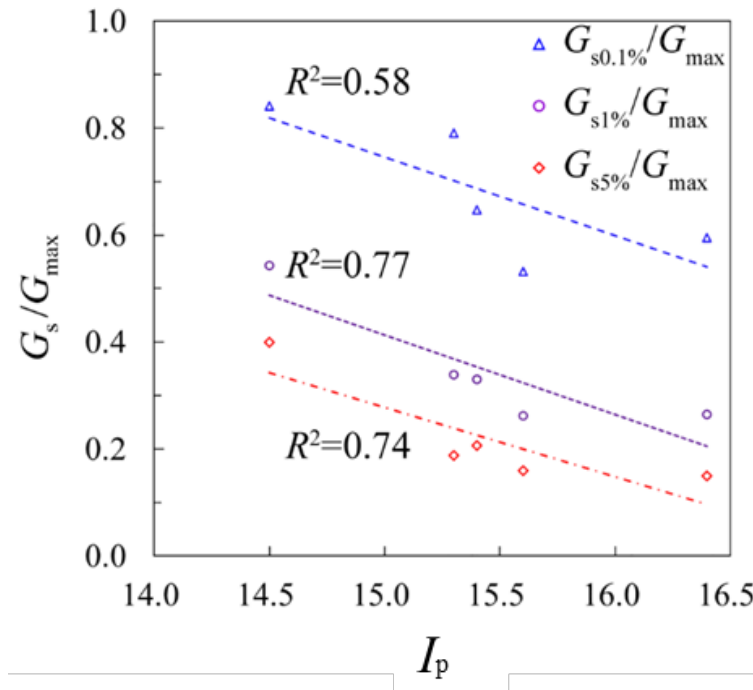
Figure 13. Correlation of G s / G max with I p.